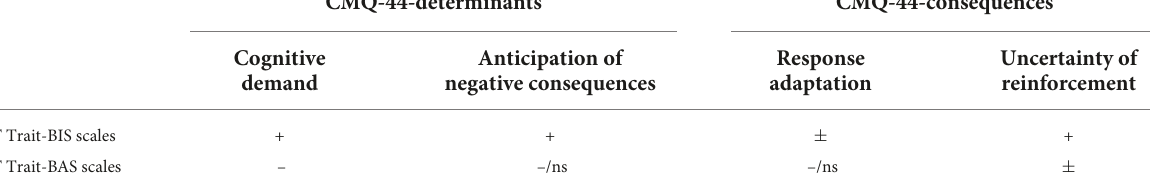
TABLE 2 Summary of predictions for CMQ-44 subscales and